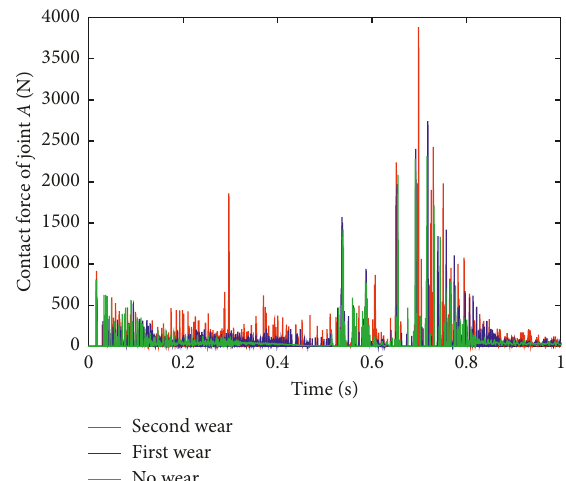
Figure 23: Contact force of joint A .